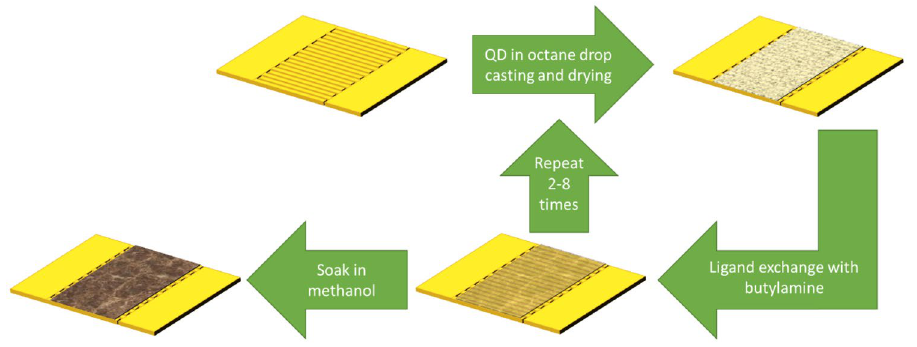
Figure 1. Device fabrication